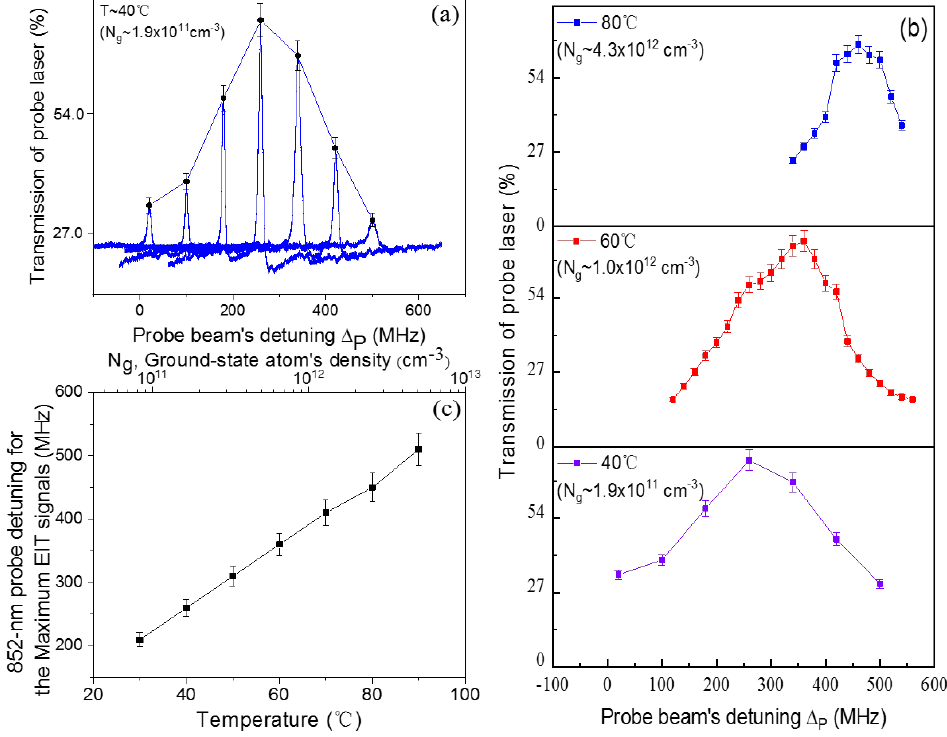
Figure 3. ( a ) At temperature of 40 ◦ C, the Rydberg EIT signal is obtained by scanning the 509-nm coupling laser frequency with different 852-nm probe laser detuning; ( b ) Rydberg EIT signal intensity versus probe laser detuning for different atomic cell temperature; ( c ) The 852-nnm probe laser detuning of the maximum intensity EIT signal changes with temperature (ground-state atomic density), including the three temperature corresponding data points in ( b ). Rabi frequency of 852-nm probe laser is ∼ 5.0 MHz, and that of the 509-nm coupling laser is ∼ 36.0